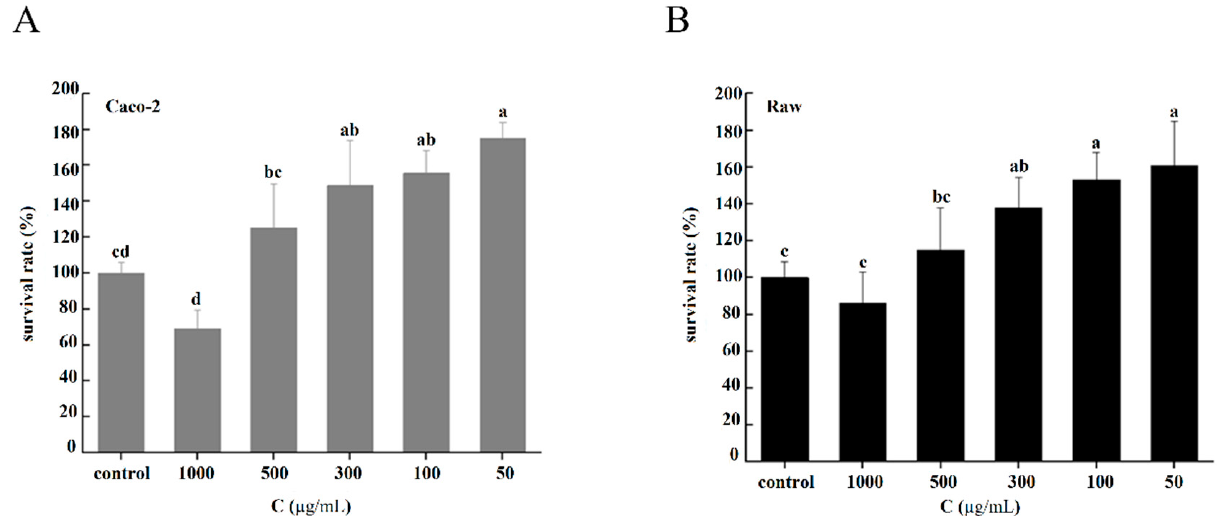
Figure 3. Cytotoxicities of the CNPs under different concentration conditions. ( A ) Cytotoxicities of CNPs on Caco-2 cells. ( B ) Cytotoxicities of CNPs on Raw 264.7 cells. Different superscript letters indicate significant differences between CNPs with different concentrations at the same time point ( p < 0.05).